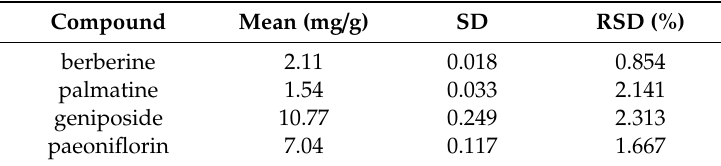
Table 4. Amounts of the four compounds in HST ( n =